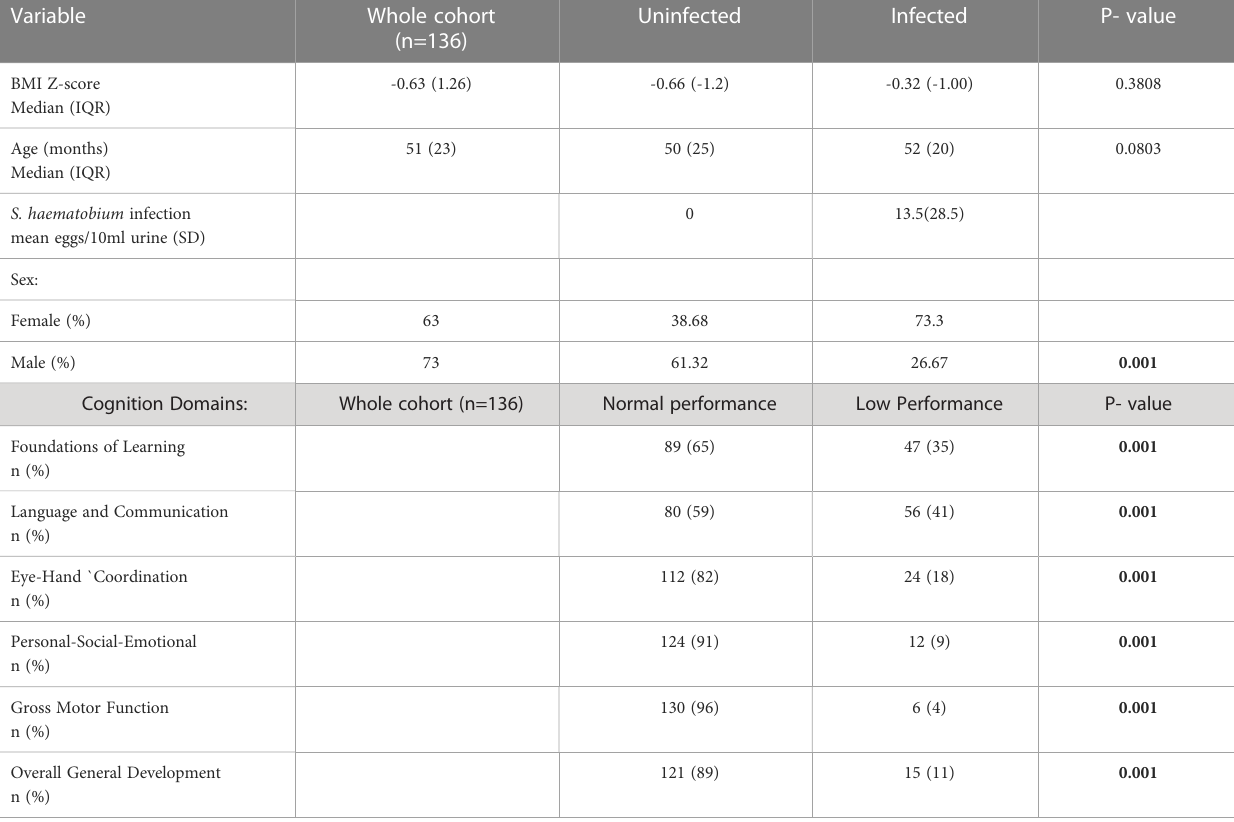
TABLE 1 Characteristics of preschool aged children who took part in the